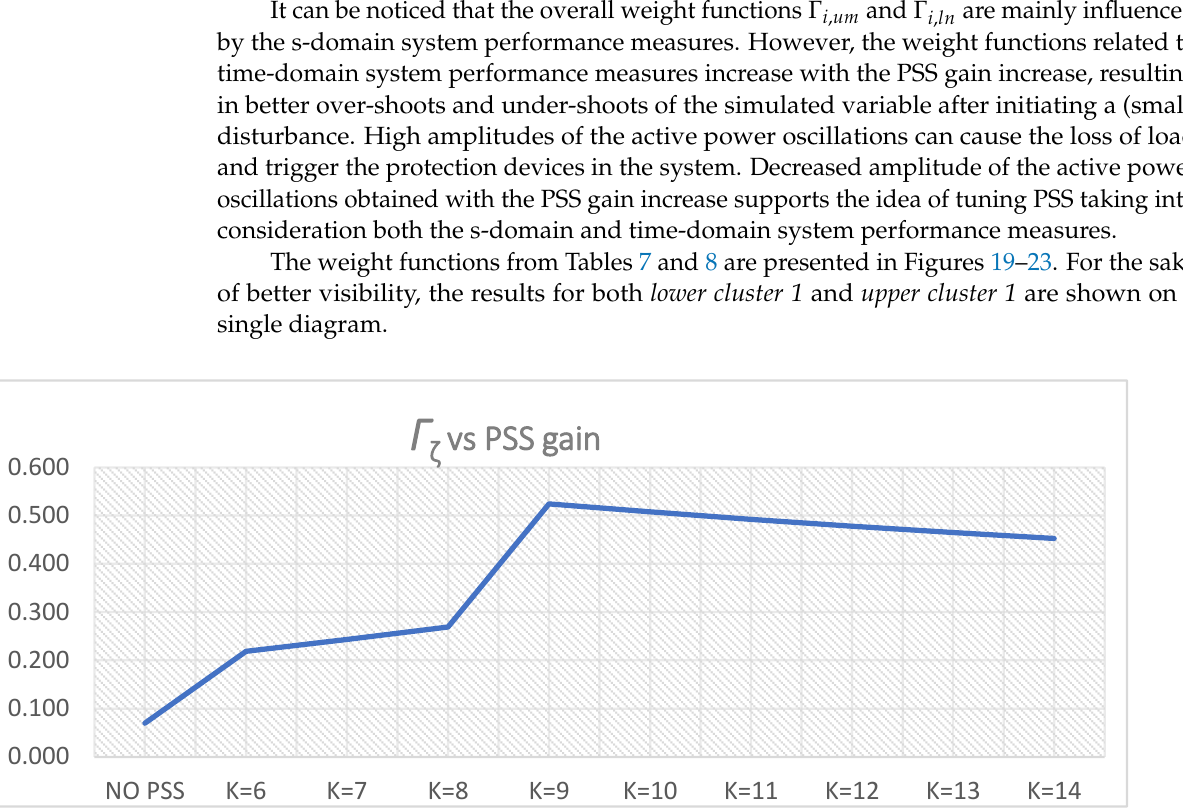
Figure 19. Γ ζ ( Γ ζi,l 1 and Γ ζi,u 1 from Table 7 and Table 8) for PSS parameters T = 0.5 s, K = 6 – 14.